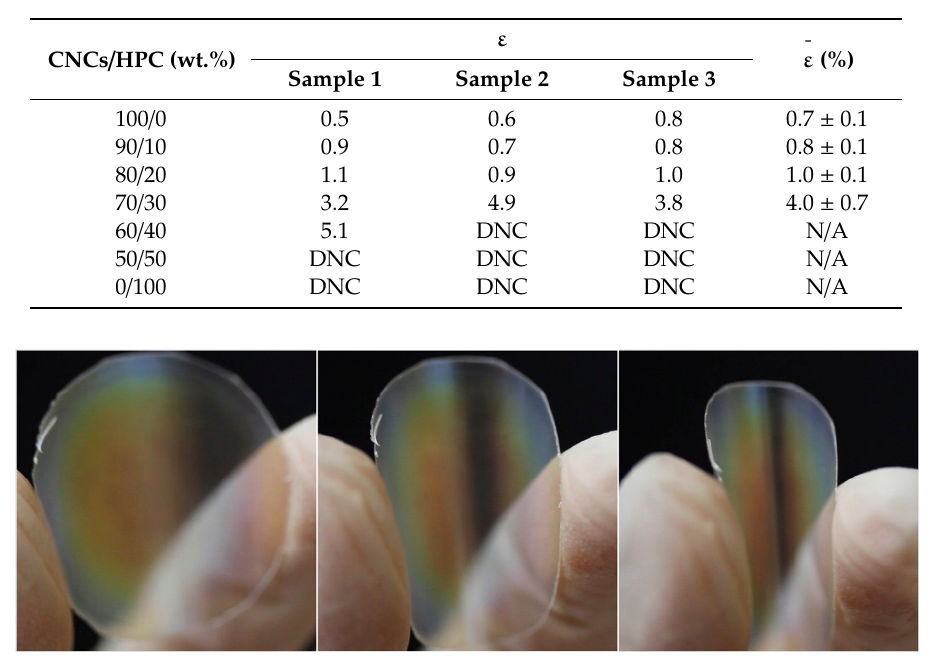
Figure 6. Sequence of images of a test where a CNCs / HPC iridescent film, with 30 wt.% of HPC, is bent (film diameter 35 mm, thickness 106 µ m) before cracks appeared.